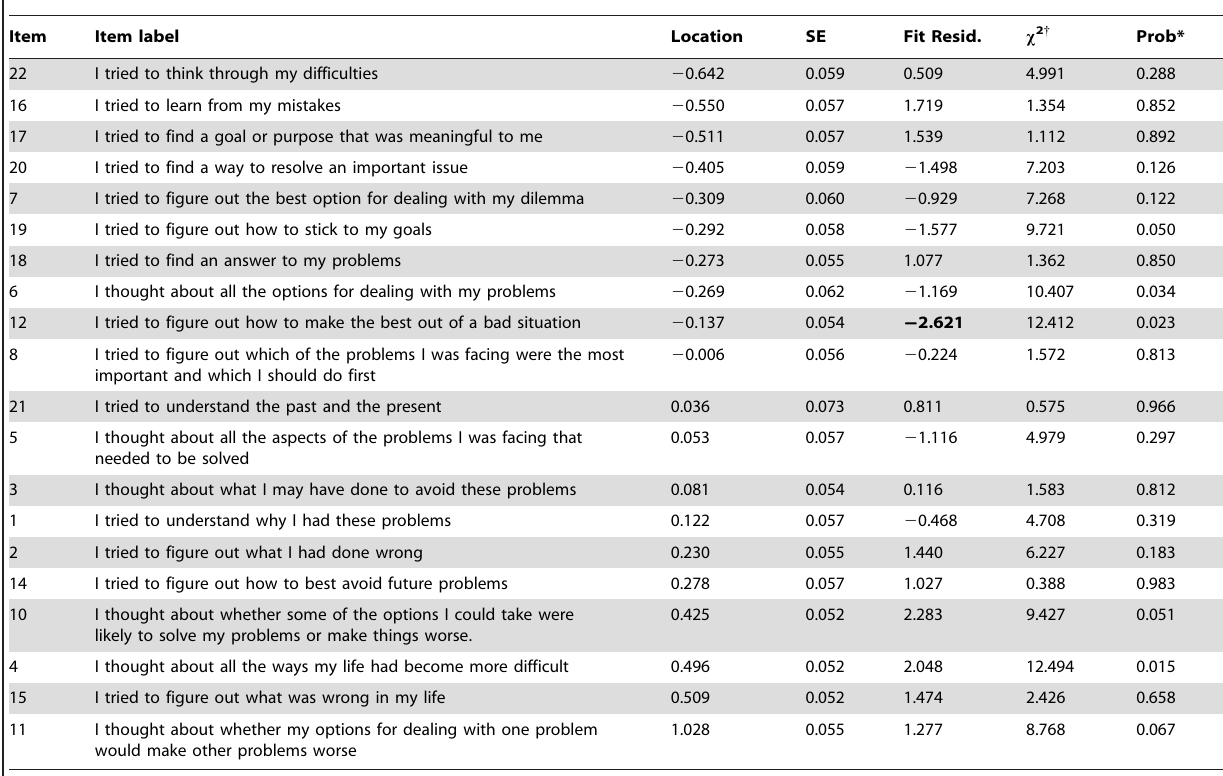
Table 2. Measures of fit and location (SE) of ARQ